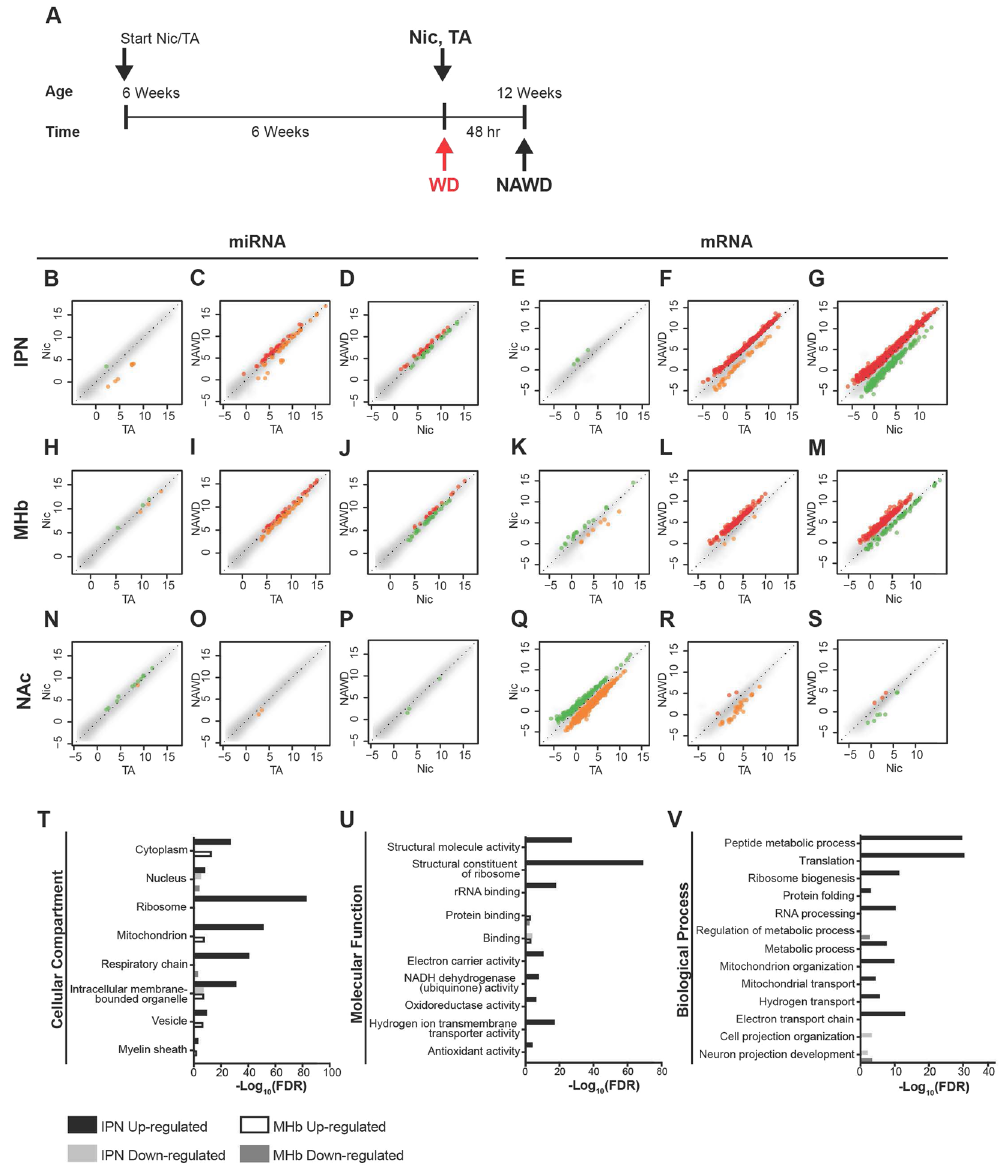
Figure 1. Differential expression of miRNAs and mRNAs within the MHb-IPN withdrawal axis and NAc during acute nicotine withdrawal. ( A ) Schematic of nicotine treatment and spontaneous withdrawal of mice used for miRNA- and mRNA-Seq. Mice were treated chronically with nicotine (Nic) or tartaric acid (TA) for 6 weeks, then either sacrificed or spontaneously withdrawn (WD) for 48 hours before sacrifice (NAWD). ( B–S ) Scatter plots displaying differential expression of miRNAs or mRNAs in the IPN, MHb, and NAc measured by deep sequencing. miRNAs isolated from tissue punches of nicotine-treated ( B,H,N ) and NAWD-treated mice are compared to TA-treated controls ( C,I,O ) or nicotine alone samples ( D,J,P ). mRNAs of nicotine-treated ( E,K,Q ) and NAWD-treated mice are compared to TA-treated controls ( F,L,R ) or nicotine alone samples ( G,M,S ). Each dot represents an individual miRNA or mRNA plotted as log 2 (RPM) or log 2 (TPM), respectively. All miRNAs with an FDR < 0.01 and mRNAs with FDR < 0.01 and FC > 2 are highlighted in color. Orange dots are up-regulated in TA compared to Nic or NAWD. Green dots are up-regulated in Nic compared to TA controls. Red dots are up-regulated in NAWD compared to TA controls. Only miRNAs with RPM > 0 and mRNAs with TPM > 0 in at least half of the replicates in each treatment group are shown. n = 4–5, with each library synthesized using pooled RNA from 4 mice. ( T–V ) Genes differentially expressed during acute nicotine withdrawal are enriched in gene ontology terms related to energetics, translation, and cell projection organization in the IPN and MHb. The vertical axes define the selected GO terms describing the cellular compartment ( T ), molecular function ( U ), or biological process ( V ). The number of GO terms was reduced combining similar terms using a sim Rel cutoff of 0.4 as described in the Materials and Methods . The horizontal axis plots the significance of enrichment of the GO term, plotted as − log 10